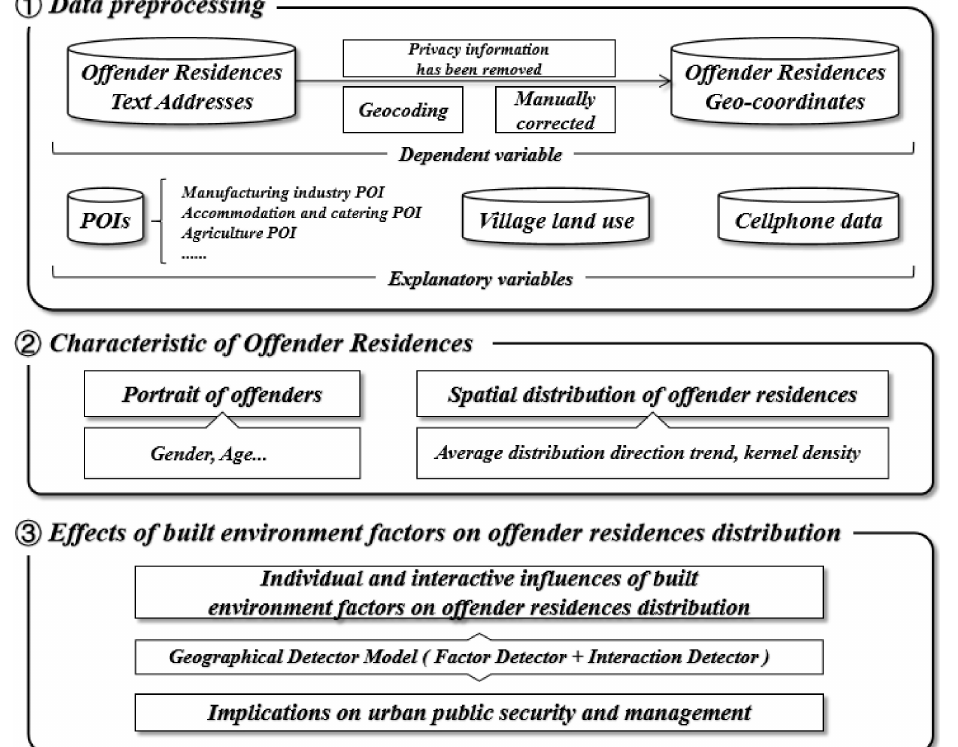
Figure 1. The workflow of this